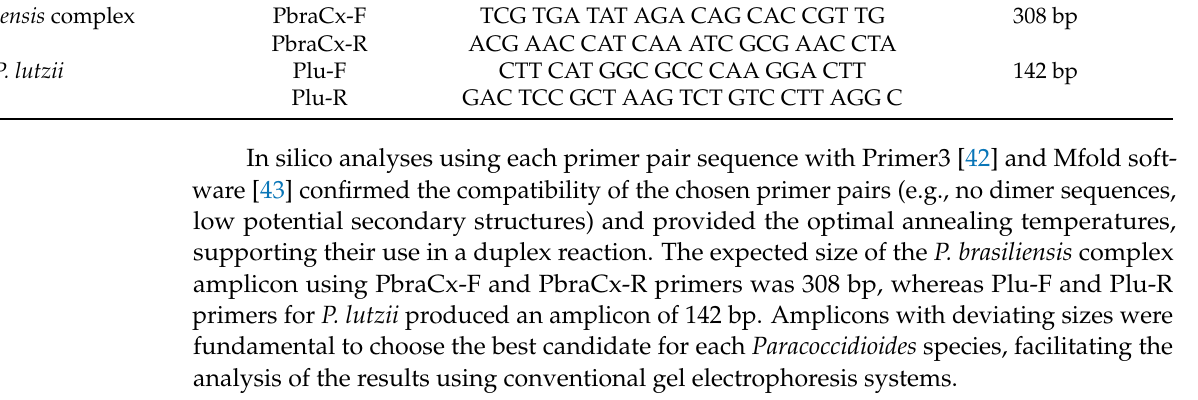
Figure 1. In silico PCR showing homology regions with sequences deposited in the GenBank. ( a ) Primers were designed to match the target gene gp43 exon-2. Primers PbraCx-F and PbraCx-R targeting P. brasiliensis complex DNA produced an amplicon with an expected size of 308 bp, while primers Plu-F and Plu-R targeting P. lutzii DNA generated an amplicon with 142 bp. ( b ) Interspecific polymorphisms in the primers’ annealing region between P. brasiliensis complex isolates and P. lutzii or between Paracoccidioides and the closely related species Lacazia loboi supported the specificity of the primers developed. Table 1. Species-specific primer sequences that targeted the gp43 gene (exon 2) in members of the genus Paracoccidioides . Target